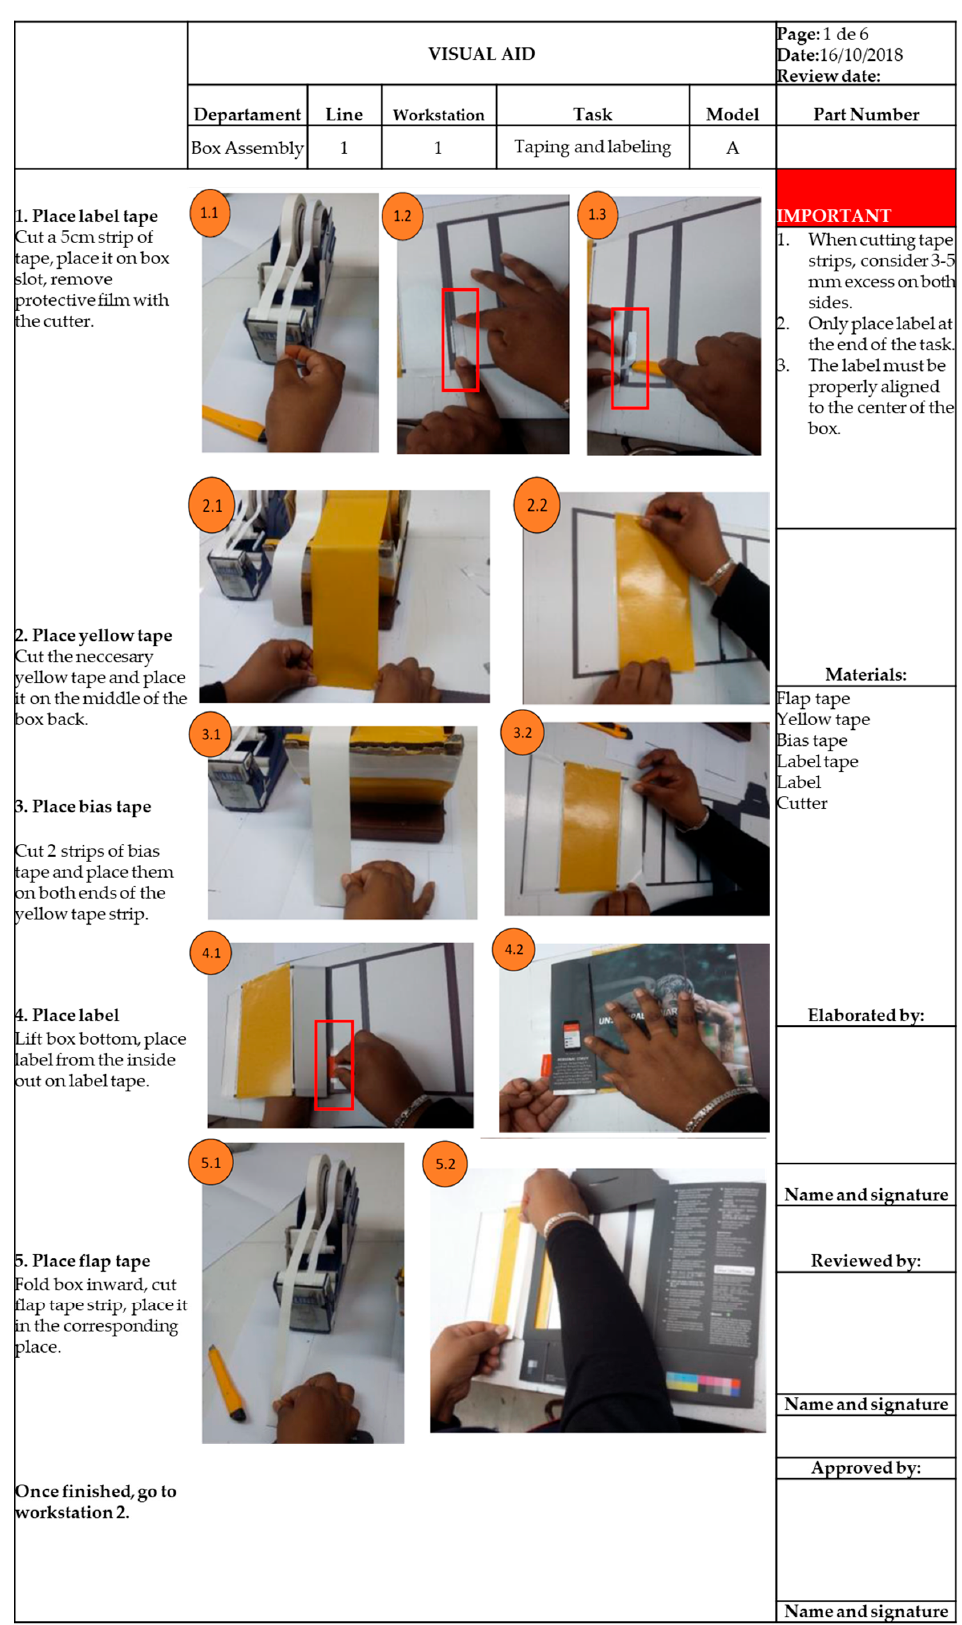
Figure 4. Visual aid for the redesigned workstation 1.